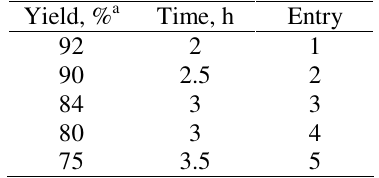
[P W O ] for synthesis of 6 2 18 62